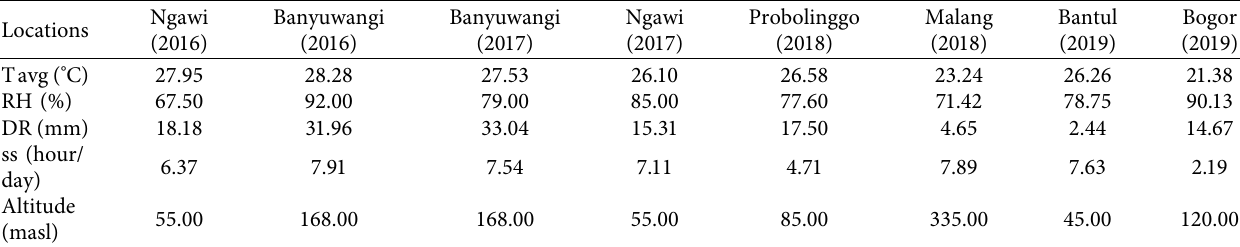
Table 1: Climate conditions in the eight environments.